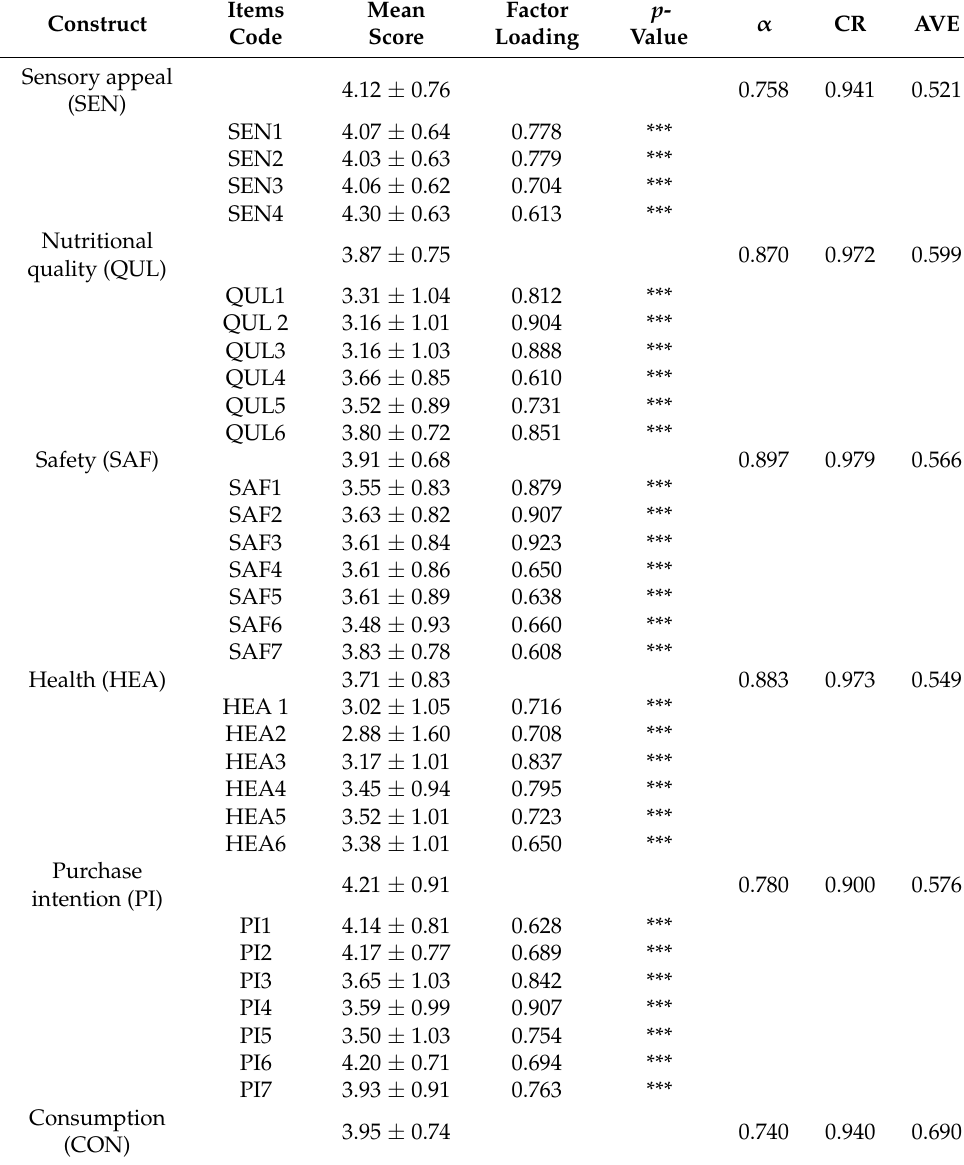
Table 2. Mean participants’ score, factor loading, Cronbach’s alpha( α ), composite reliability (CR), and average variance extracted (AVE) of product determinants influencing purchase intention, consumption, and satisfaction of consumers for convenience